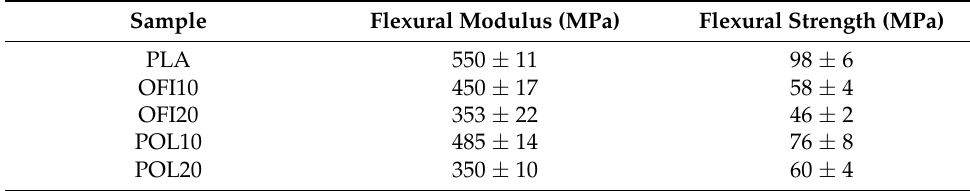
Table 4. Flexural properties of the 3D printed samples.